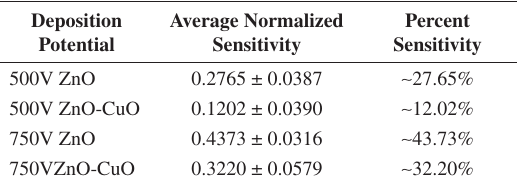
Table 2. Normalized sensitivity (±uncertainty) of materials at different deposition potential.